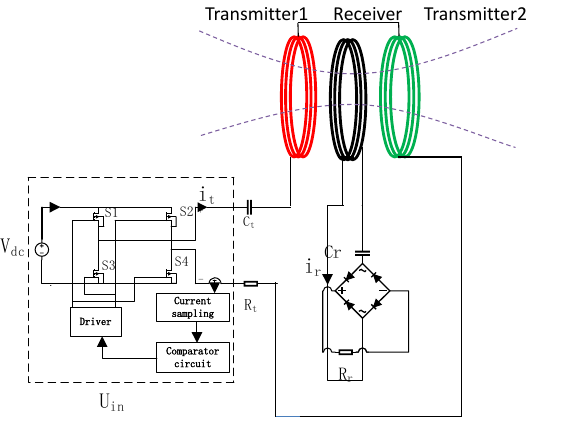
Figure 4. Single transmitter circuit PT-symmetric radio energy transmission structure diagram.